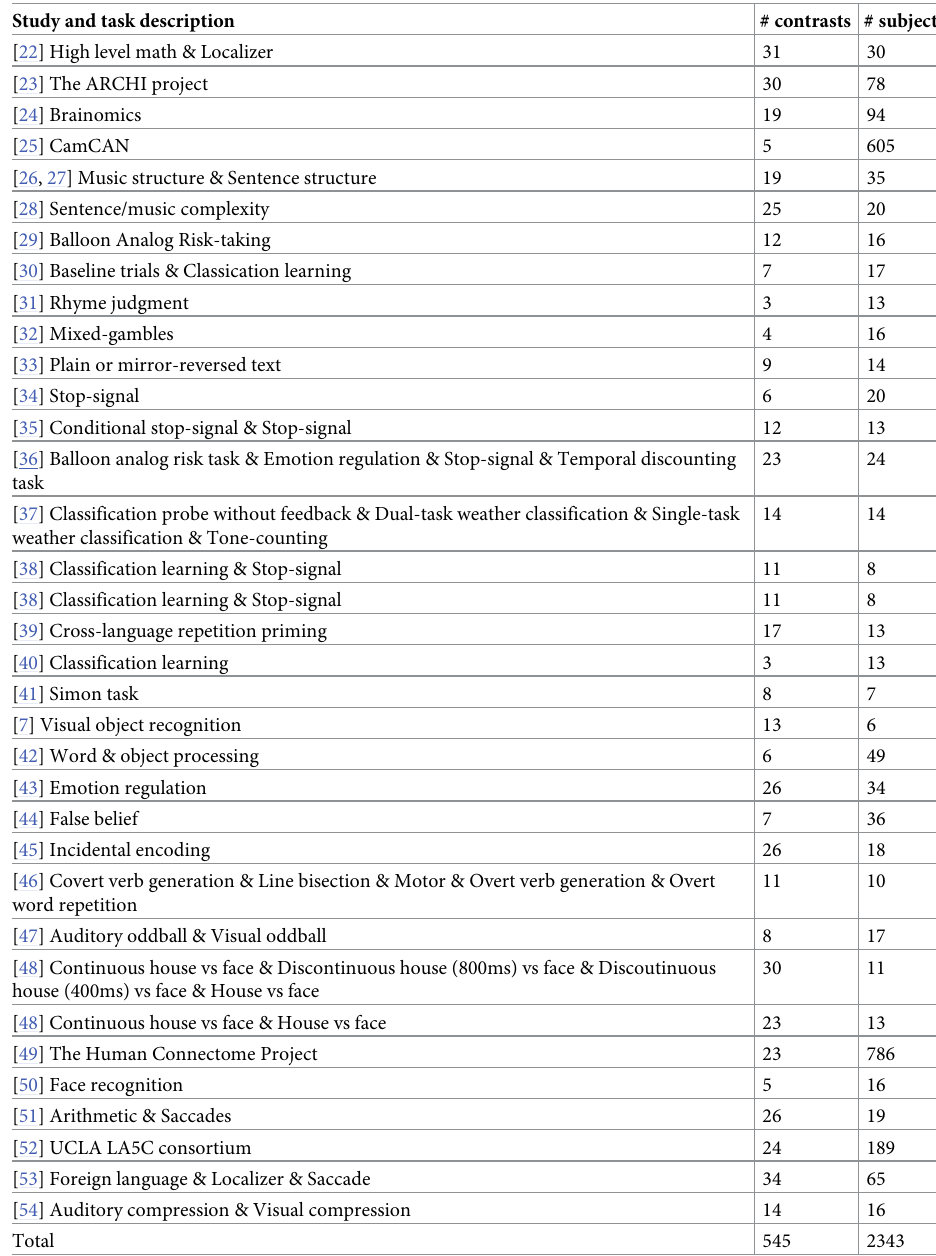
Table 1. Training and experiment set of fMRI studies. Note that even though some tasks are similar, they may feature different contrasts. Task correspondence is not encoded explicitly in our model. Table C in S1 Appendix lists each con- trast used in each